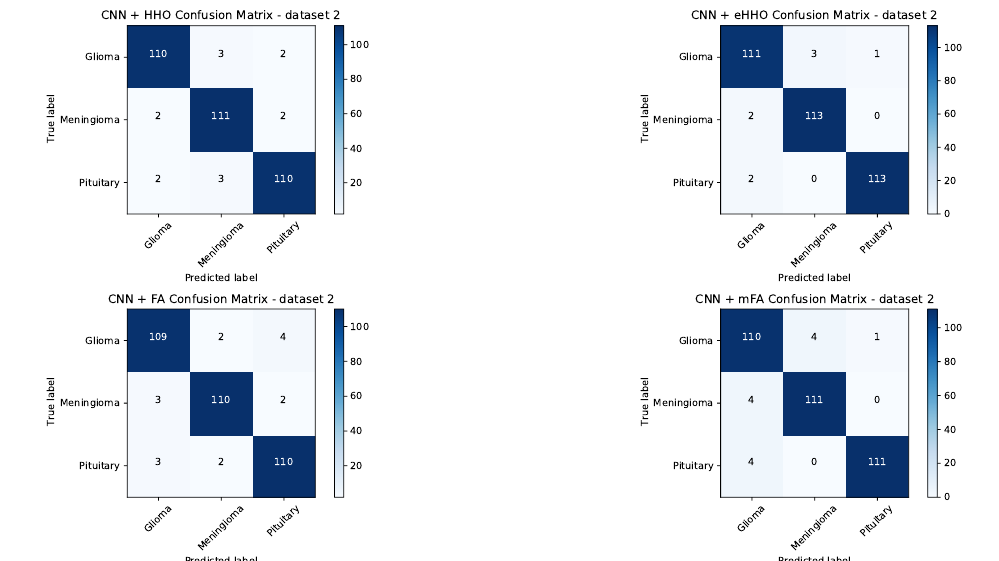
Figure 10. Confusion matrix for dataset2 with a direct comparison between proposed CNN + eHHO, CNN + HHO, CNN + FA and CNN + mFA